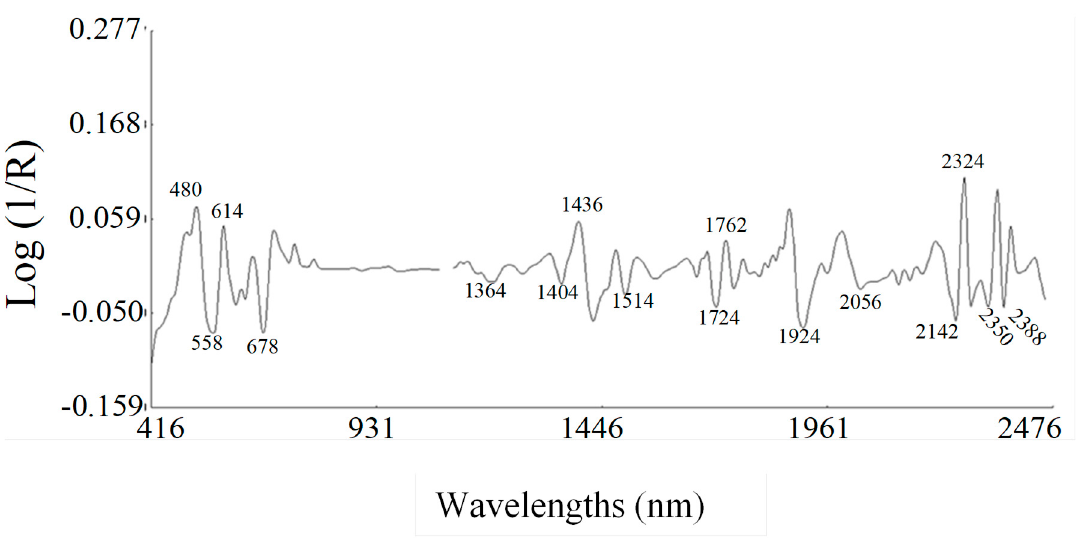
Figure 2. Second-derivative NIR spectra of blueberry samples.